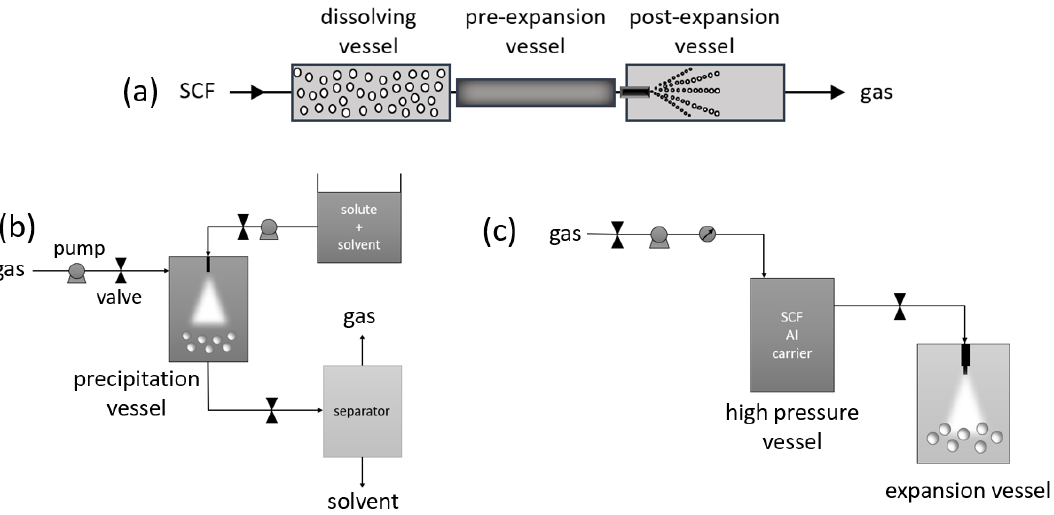
Figure 2. Shematic representation of SCF micronization processes: ( a ) RESS, ( b ) SAS, and ( c ) PGSS TM . Adapted from [32 –